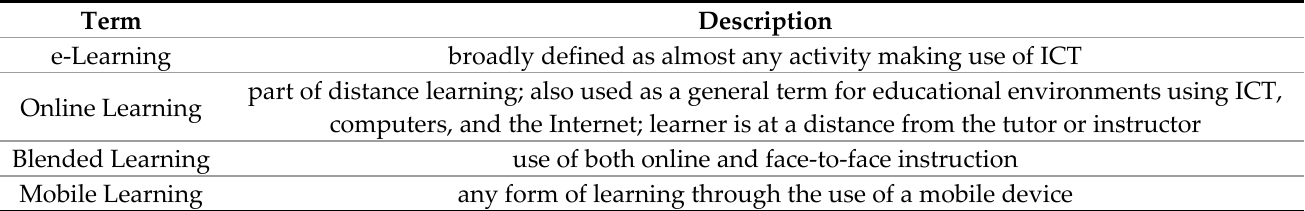
Table 1. Terms used to describe educational and training environments based on technological (use of ICT) and geograph- ical (distance from the location of instruction) characteristics.